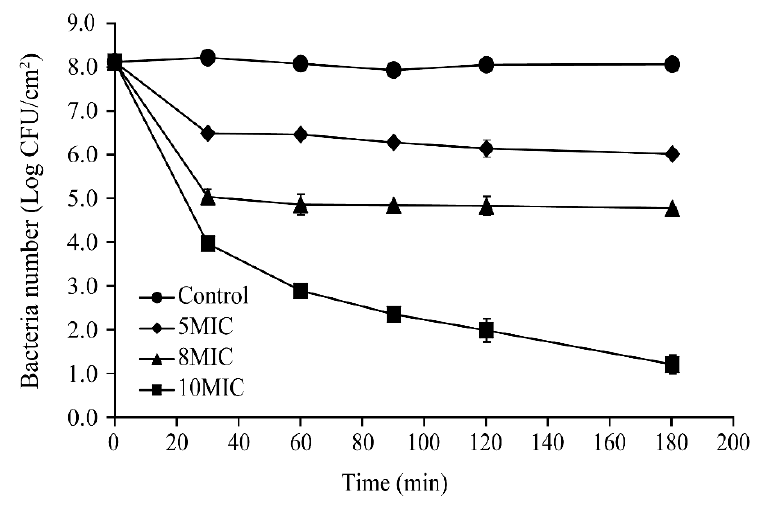
Figure 9. Inactivation of biofilm-associated S. Typhimurium ATCC 14028 cells on stainless steel surfaces following CoQ 0 treatment. ( ● ) Control, ( ♦ ) 5MIC, ( ▲ ) 8MIC, ( ∎ ) 10MIC. Control repre- sents no CoQ 0 added.